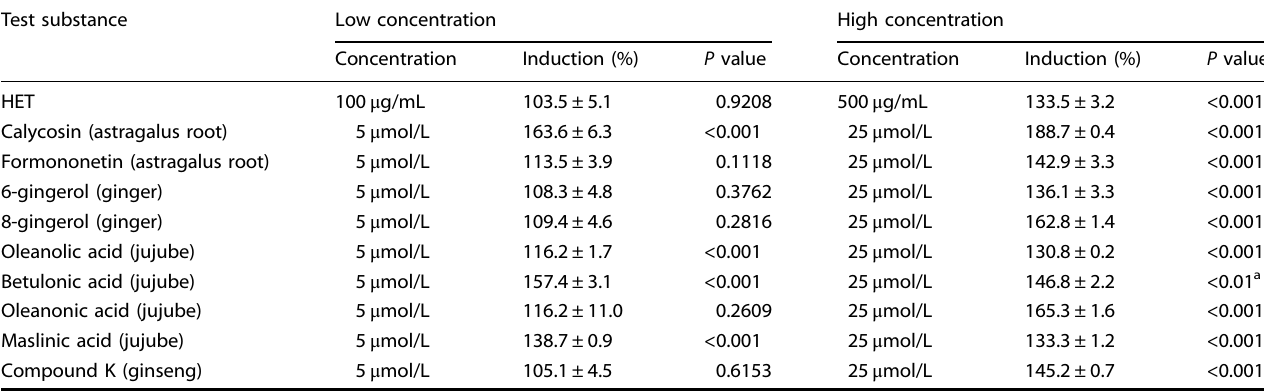
Table 1. Autophagy induction (% of control) by hochuekkito (HET) and its active ingredients in vitro. Test